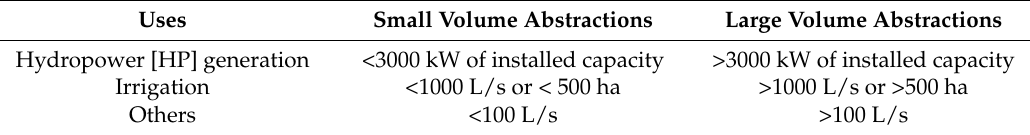
Table 2. WAL differentiation by type of use (source: